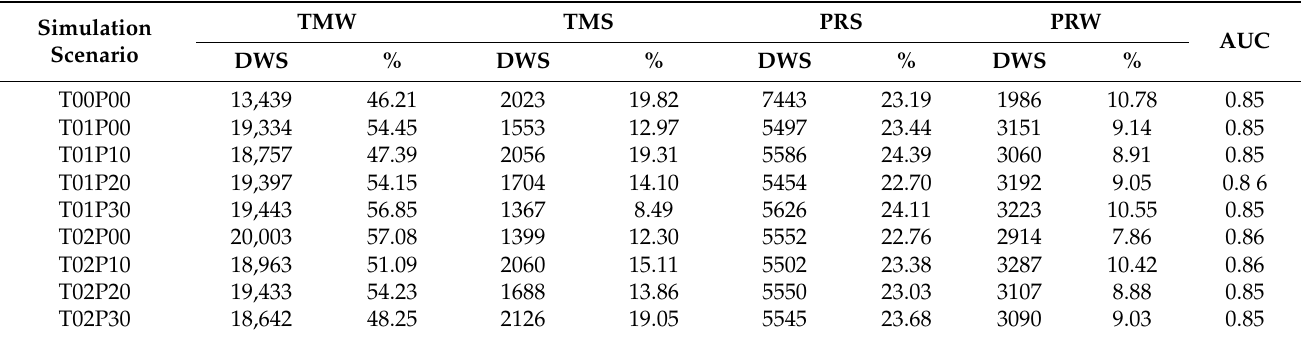
Table 2. The deviance-weighted scores, percentage of each climatic variable, and area under the curve for each simulation